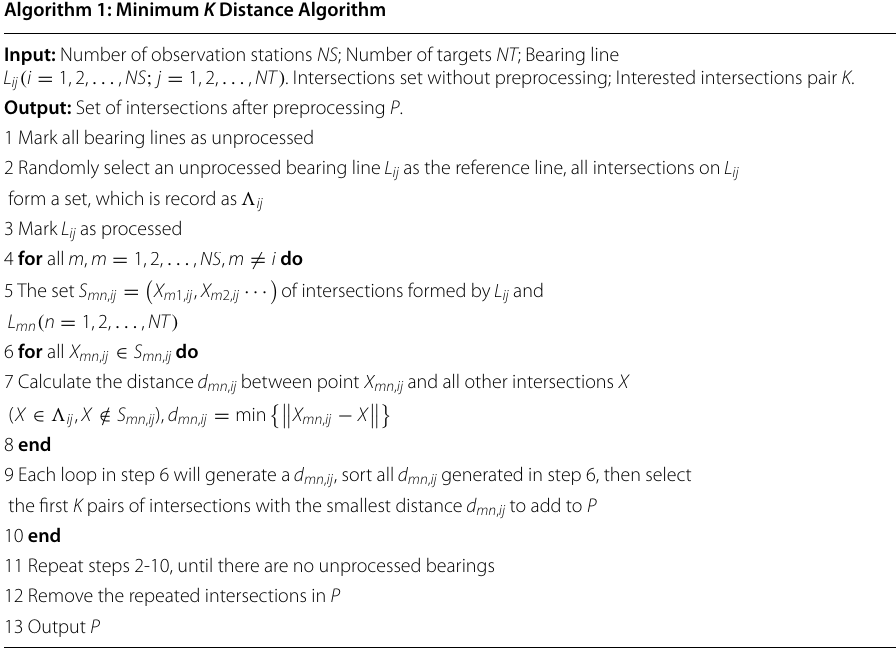
Algorithm 1: Minimum K Distance